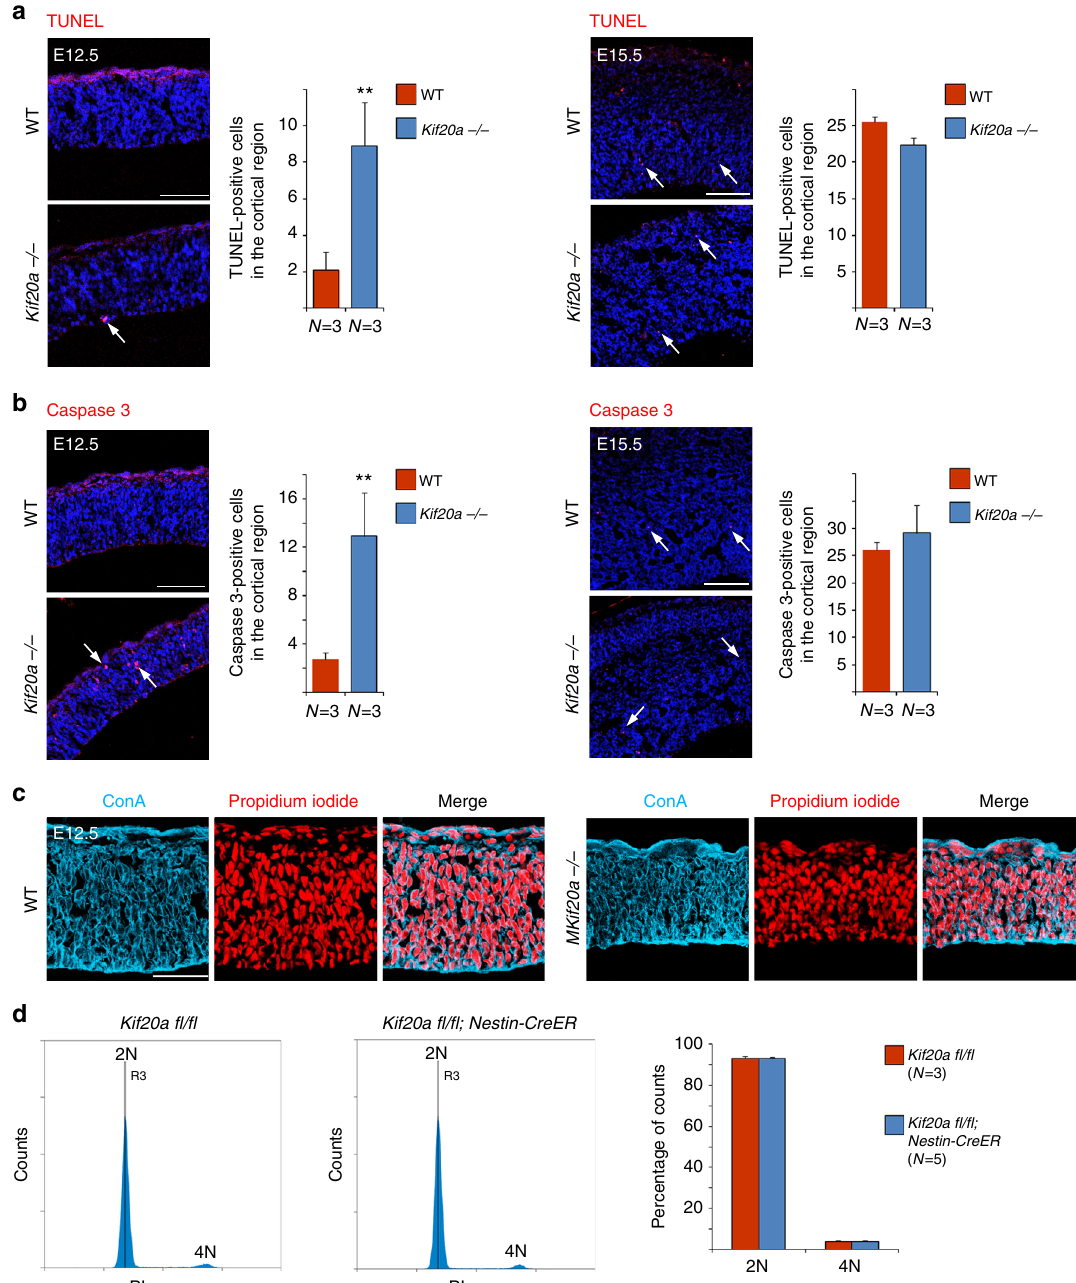
Fig. 6 Knockout of Kif20a causes a subtle increase in apoptosis without obvious defect in cytokinesis. a TUNEL staining for visualizing cells in apoptosis. An increase of numbers of apoptotic cells in the Kif20a germline knockout mutant cortices was seen at E12.5. Apoptosis status in the mutant and wild-type cortices appeared comparable at E15.5. Scale bar represents 100 μ m. TUNEL-positive cells in the entire cortical region were counted. ** P < 0.01. b Anti- activated caspase 3 staining for detecting cells in apoptosis. Staining of activated caspase 3 showed a similar trend of apoptosis status in the germline knockout mutant and wild-type cortices to TUNEL staining. Scale bar represents 100 μ m. Caspase 3-positive cells in the entire cortical region were counted. ** P < 0.01. c No obvious bi- or multinucleated cells were seen in the wild-type or Kif20a germline knockout mutant cortices. ConA (cyan) and propidium iodide (red) were used for visualizing cell peripherals and nuclei, respectively. Scale bar represents 100 μ m. d Cell cycle analysis of wild-type and mutant cortical cells. Tamoxifen was administered to Kif20a inducible knockout mice at E9.5 and E10.5 consecutively. Littermates of Nestin-CreERT2 ; KIF20A fl / fl and control KIF20A fl / fl embryos were collected at E15.5. Cortical cells were examined for their DNA contents by FACS analysis. PI propidium iodide, 2N cells in G1/S phase, 4N cells in G2/M phase or bi-nucleated cells. No obvious difference in DNA content of cortical cells was observed ( P = 0.73 and 0.93 for 2N and 4N,